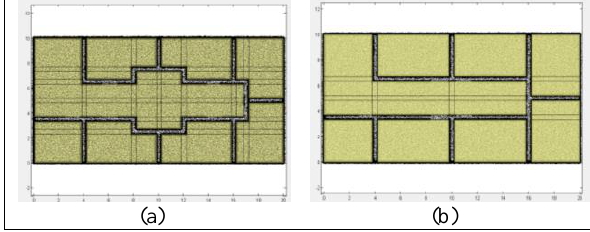
Figure 8. Connecting cuboids of the first floor (a) and the second floor (b) by iteratively applying the second rule.